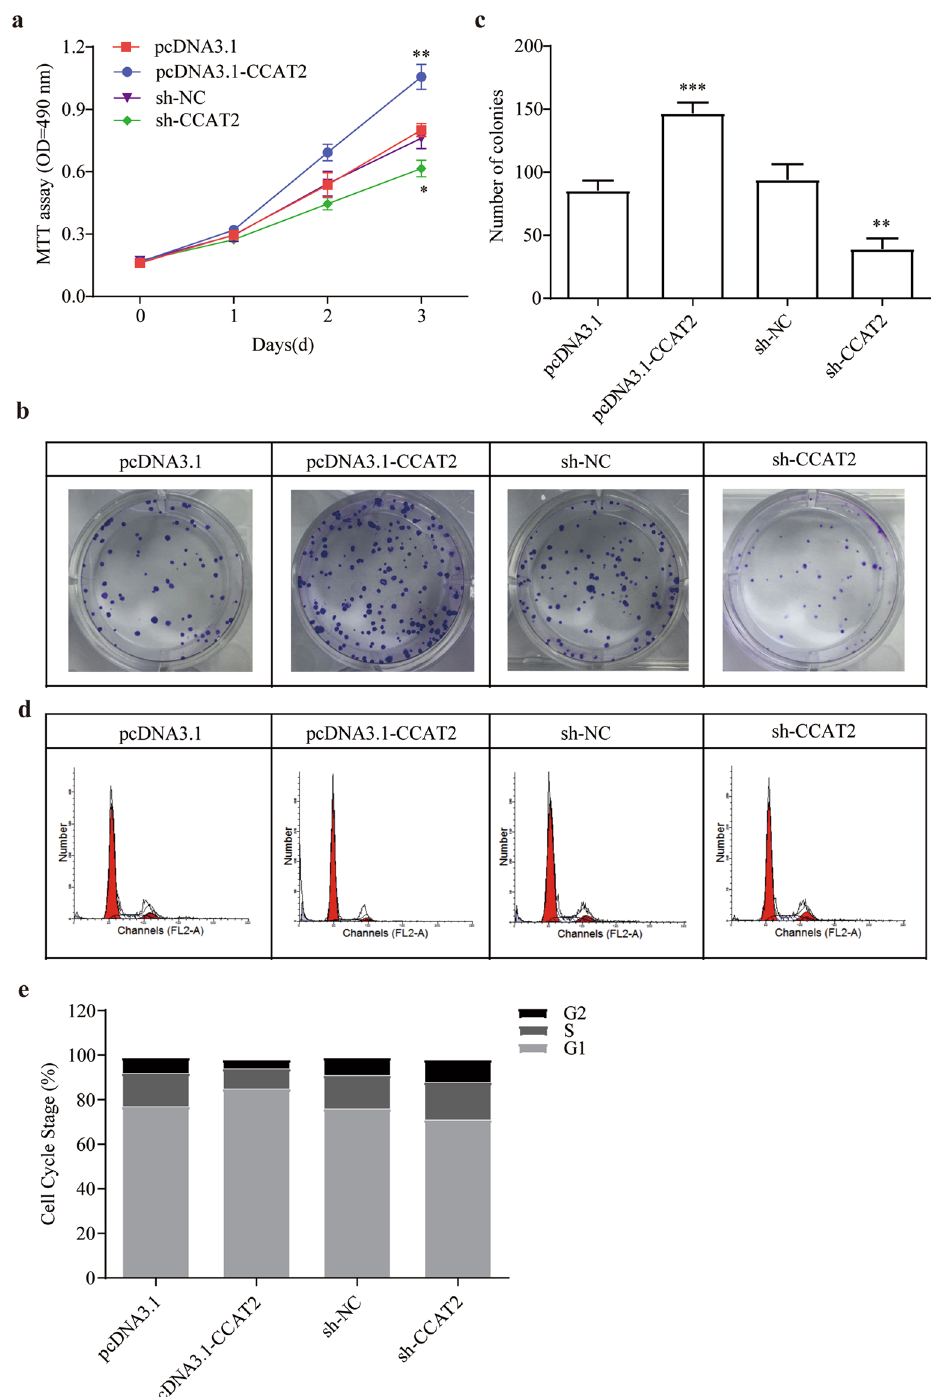
Figure 1. CCAT2 effects on lx-2 cell proliferation, collagen precipitation and apoptosis. ( a ) Comparison of cell viability of lx-2 cells transfected with sh-CCAT2 or pcDNA3.1-CCAT2 was determined by MTT assay. ( b ) and ( c ) Colony formation assay and the quantification. ( d ) and ( e ) Cell-cycle distribution by flow cytometry, and statistical analysis of distribution of lx-2cell cycle